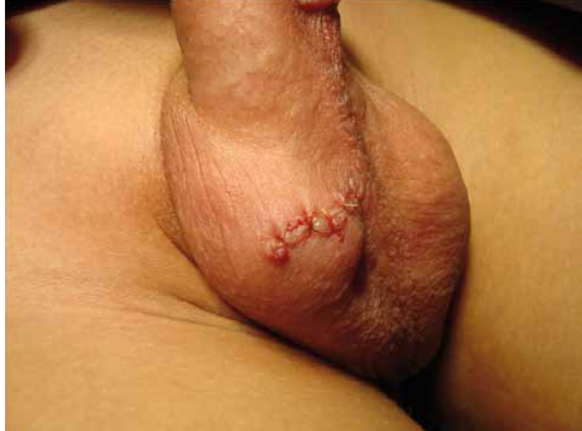
Figure 1b - Final appearance for unilateral undescended testis.